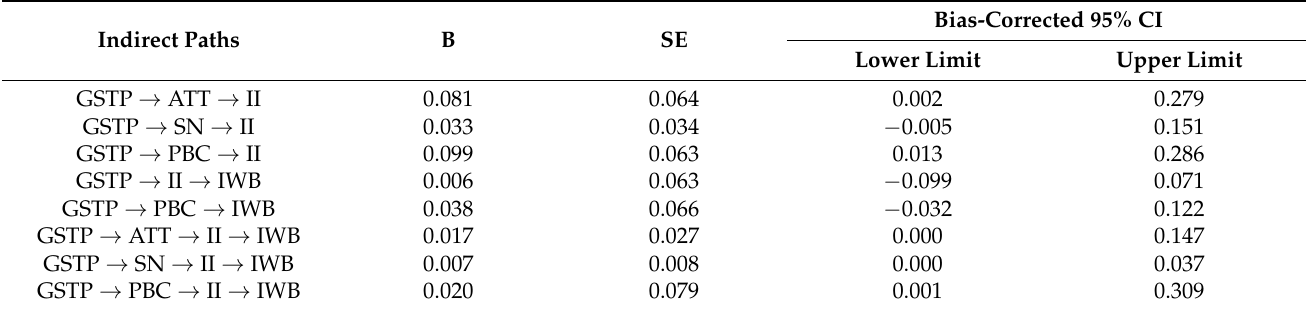
Table 5. Results of indirect effects test based on the bias-corrected bootstrapping